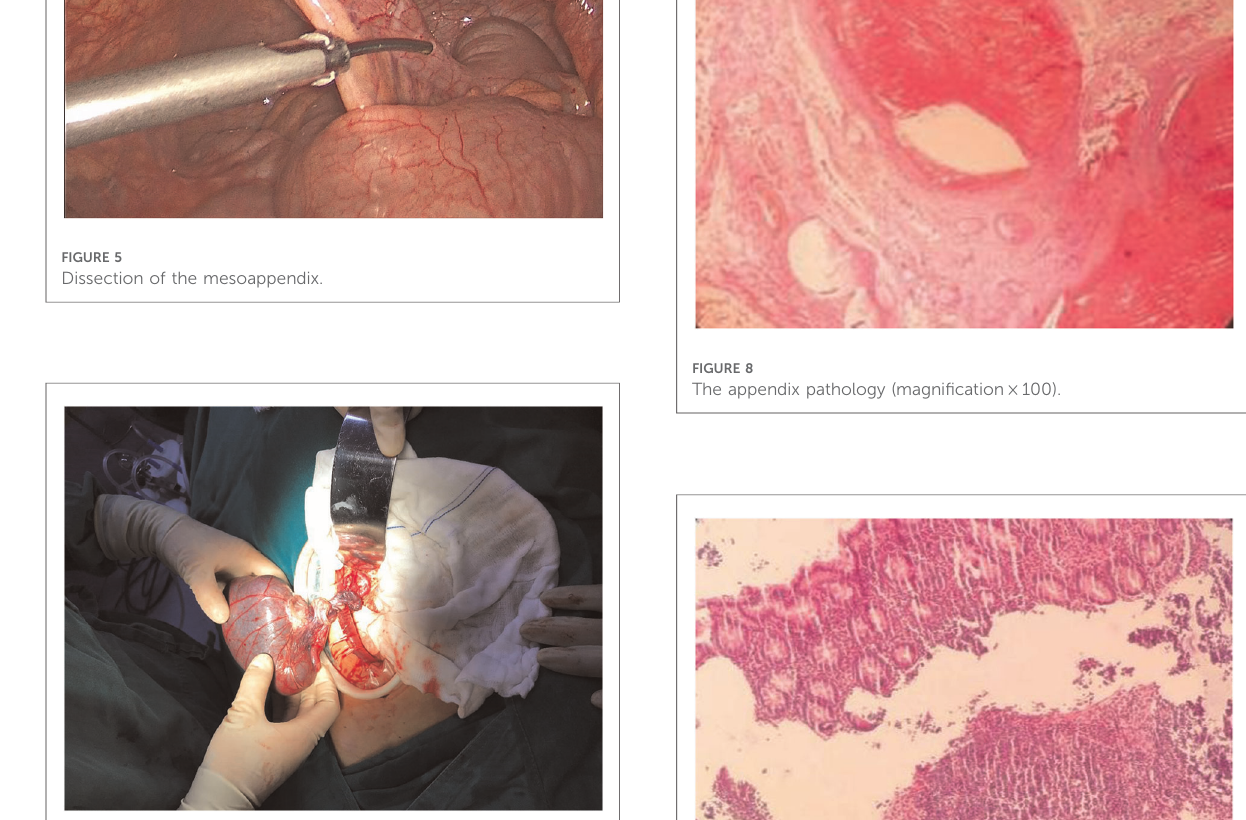
FIGURE 6 The resected infarcted spleen.